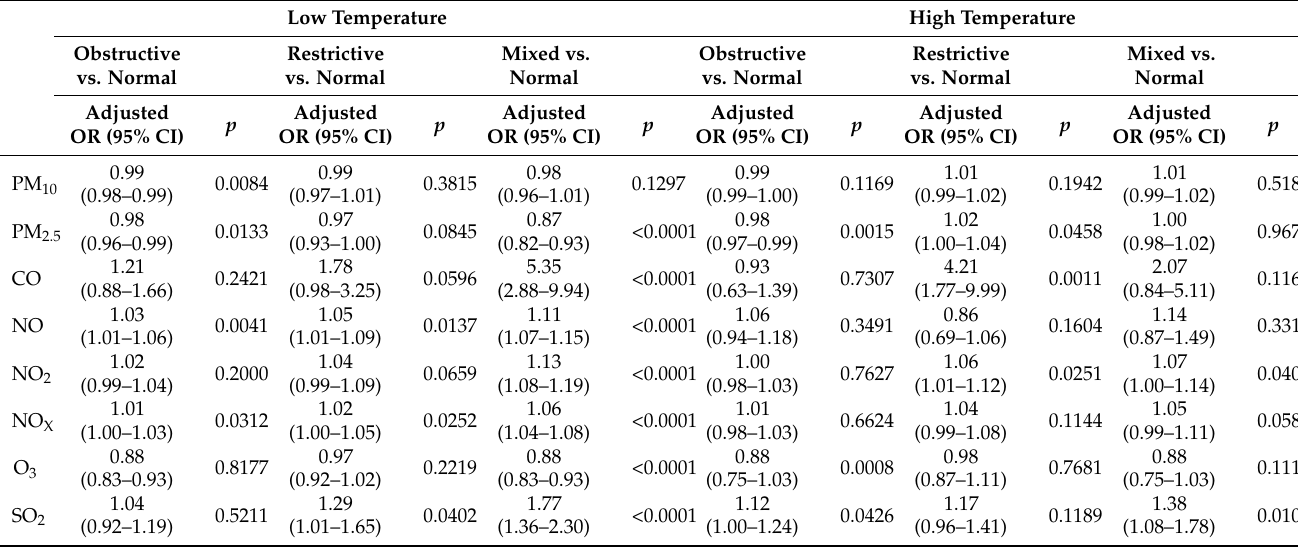
Table 3. Interactions between temperature and air pollutants.